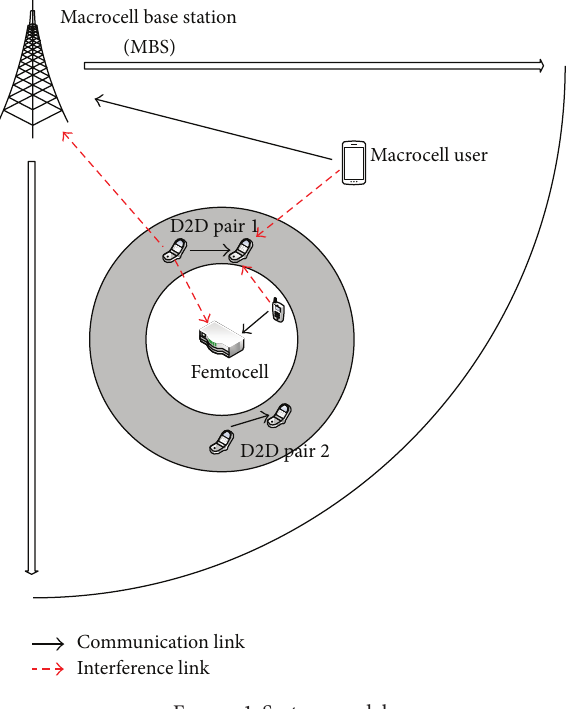
Figure 1: System